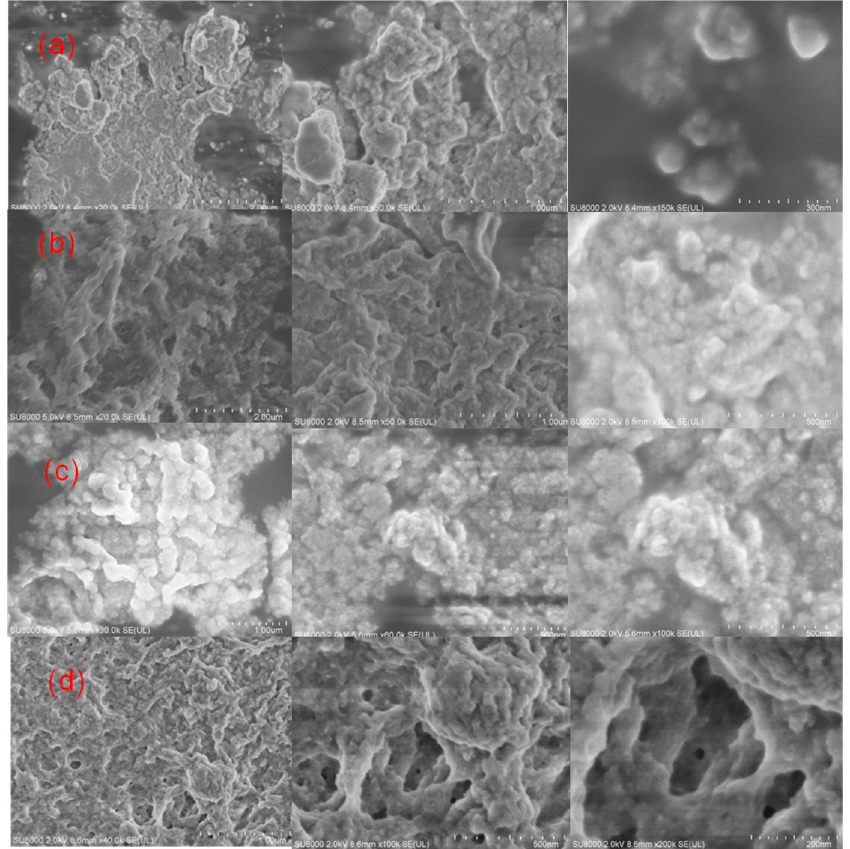
Figure 3. SEM images of two ionic self-assemblies. ( a ) COOH-PL@P-POM, the viscosity average FW of the counter polycation is 23,000; ( b ) COOH-PL@Si-POM, the viscosity average FW of the counter polycation is 23,000; ( c ) COOH-PL@P-POM, the viscosity average FW of the counter polycation is 15,000; ( d ) COOH-PL@Si-POM, the viscosity average FW of the counter polycation is 15,000.